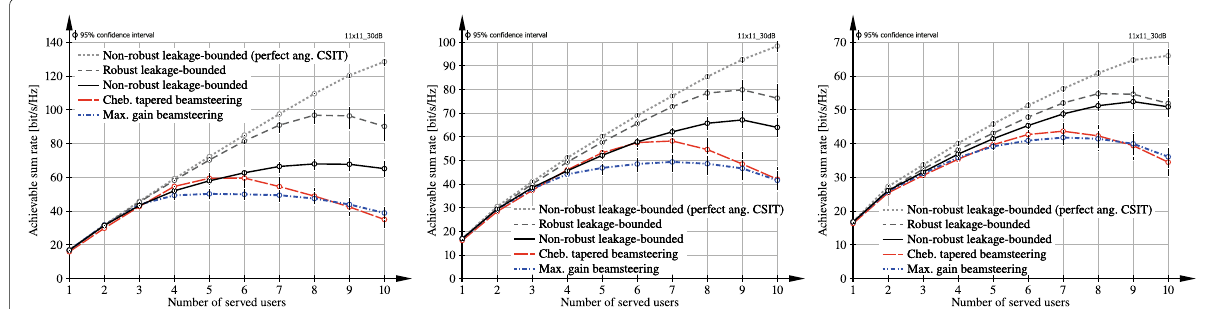
Fig. 3 Comparison of the achievable sum rate of different single-stream beamforming methods with varying K factor. a Achievable sum rate with K = 10 3 . b Achievable sum rate with K = 10 2 . c Achievable sum rate with K =